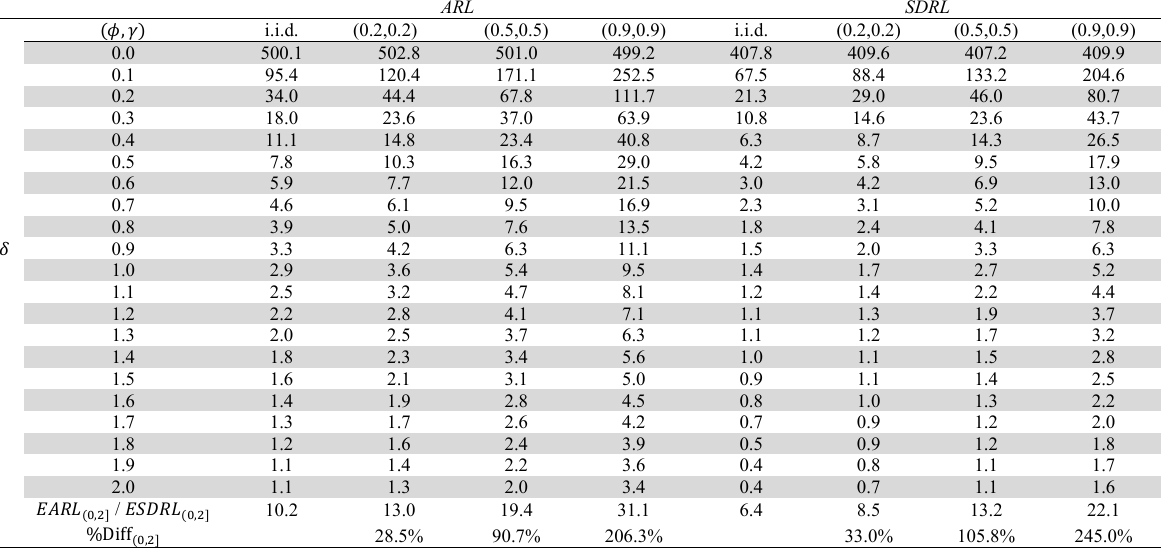
The ARL and SDRL profiles of the HWMA 𝑋(cid:3364) ∗ scheme (for the no remedy strategy) when 𝜆 =0.1, 𝑛 =5, 𝐵 =1 and 𝐴𝑅𝐿 where ( 𝜙 , 𝛾 ) ∈ {(0.2, 0.2), (0.5,0.5), (0.9,0.9)}